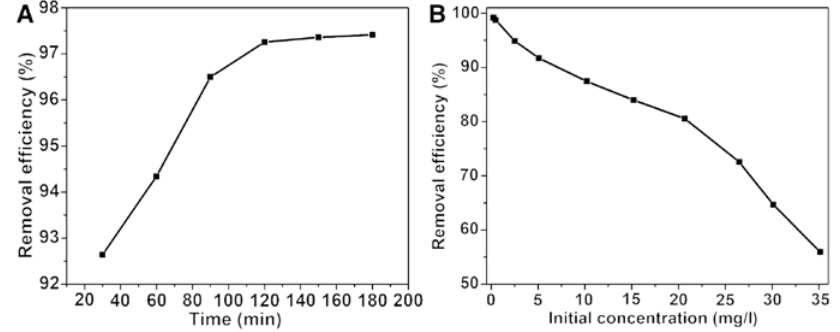
Figure 4: Effect of (A) contact time and (B) initial concentration on the As(III) adsorption.